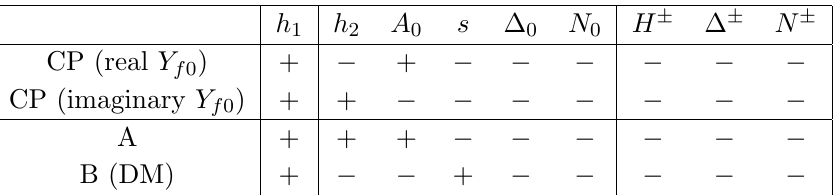
Table 1 . Parities assignment of the pNGBs under CP, and A and B: for the charged states, it is left understood that they transform in their complex conjugates (anti-particles) under CP